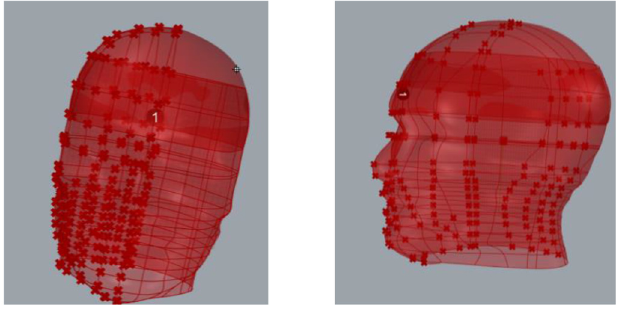
Fig. 8. Parametric model of